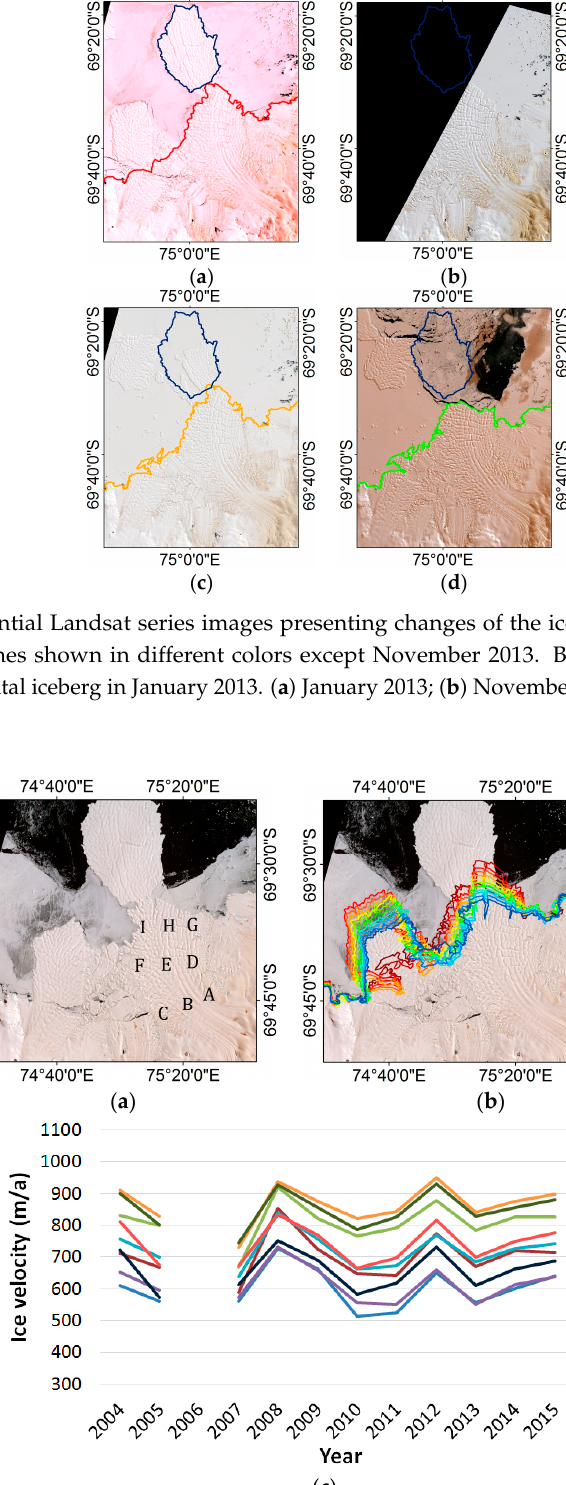
Figure 12. Point C became open water after 2009 due to the iceberg motion.